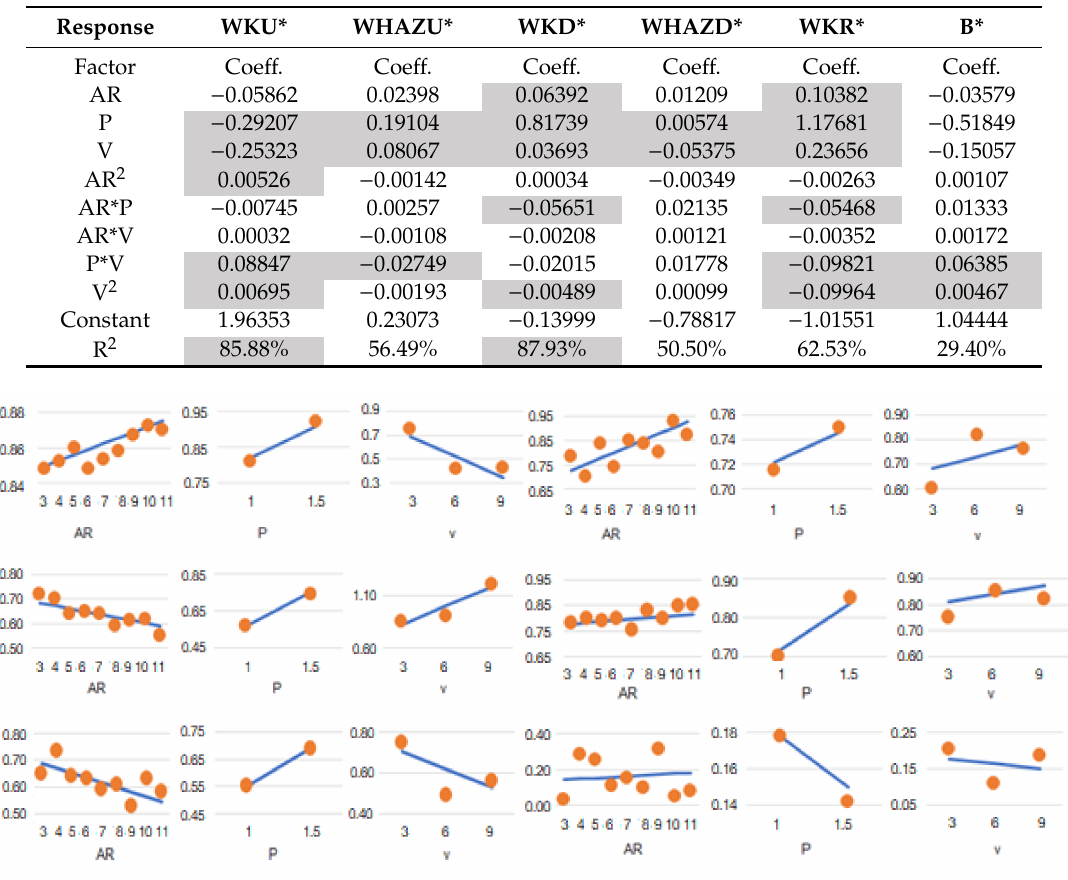
Table 5. Summary of linear models with interactions (e.g., WKU* = 1.96353 + 0.00695 · V 2 + 0.08847 · P*V